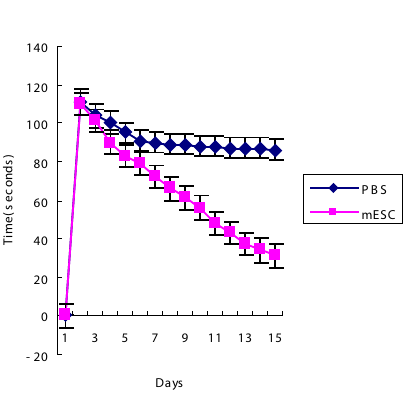
FIGURE 4B - Somatosensory function was examined between control group and mESC-transplanted group. Improved somatosensory function was shown in transplanted group. P<0.05 compared with PBS (n=10) only; P<0.05 compared with cell transplanted group (n=14).